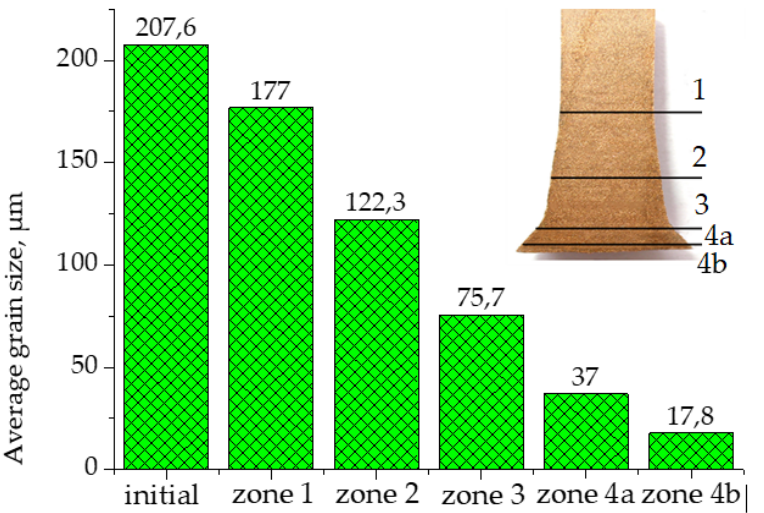
Figure 11. Average grain size in the non-deformed specimen and in the different zones of the deformed specimen for an impact velocity of 316 m/s.